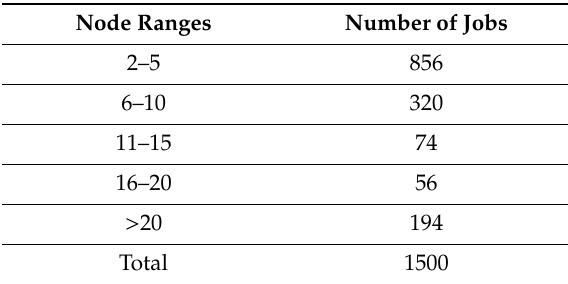
Table 8. The number of nodes per job (non-operational) in the validation experiment’s new dataset. Node Ranges Number of